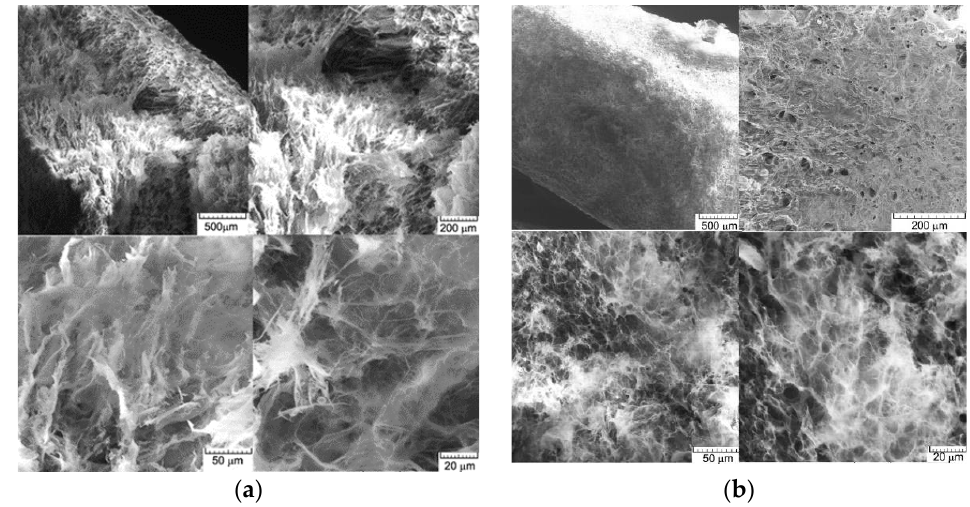
Figure 3. Scanning electron microscopy (SEM) of the biosorbent after ( a ) and before ( b ) Methylene Blue cationic dye biosorption.